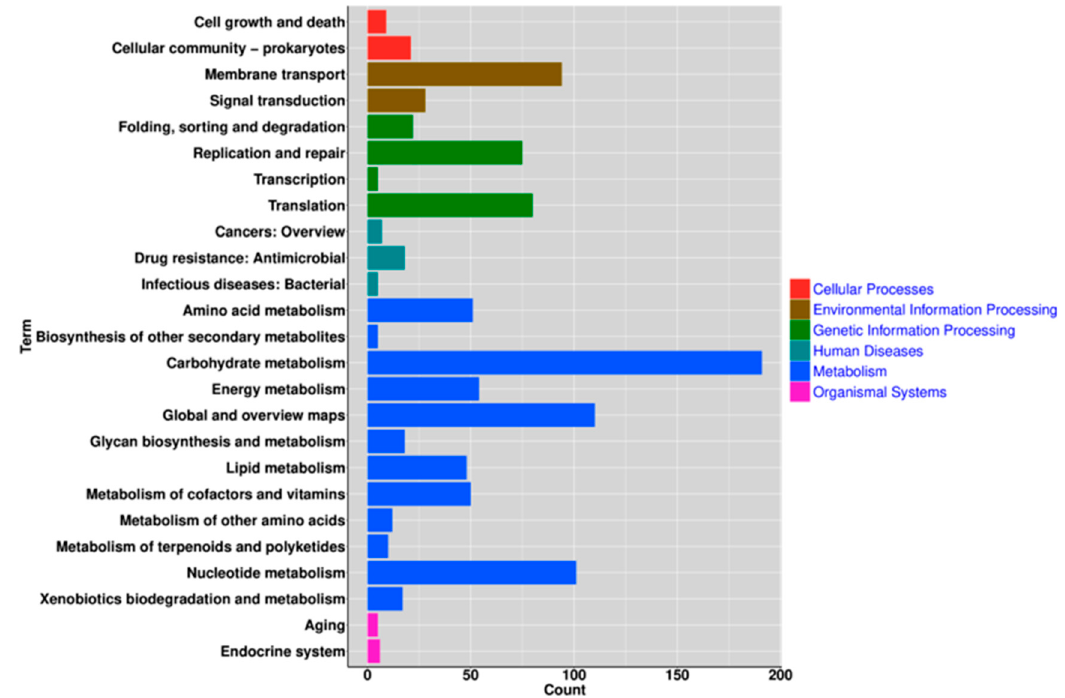
Figure 7. The KEGG annotation of the L. sakei genome.